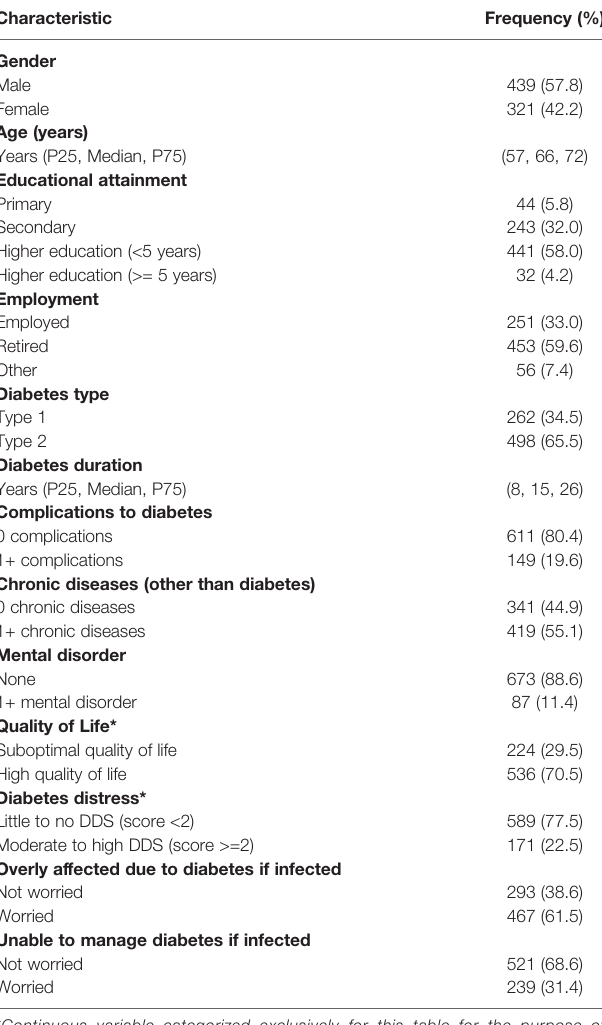
TABLE 1 | Baseline characteristics of the study population (N =